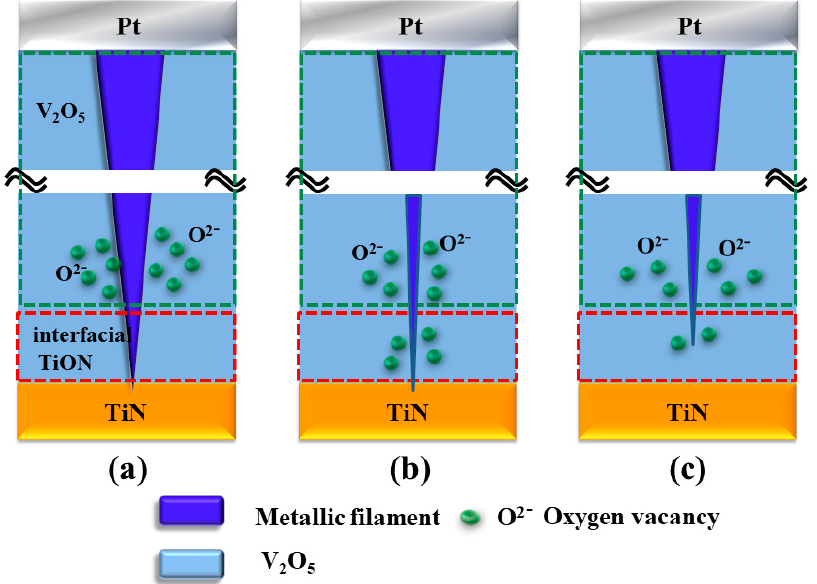
Figure 7. The electrical conduction model of ( a ) initial positive bias applied ( b ) the metallic filament path continuously decreased by the oxygen atoms, ( c ) the metallic filament rupture caused by oxidation reaction for the vanadium thin film RRAM devices in reset state.